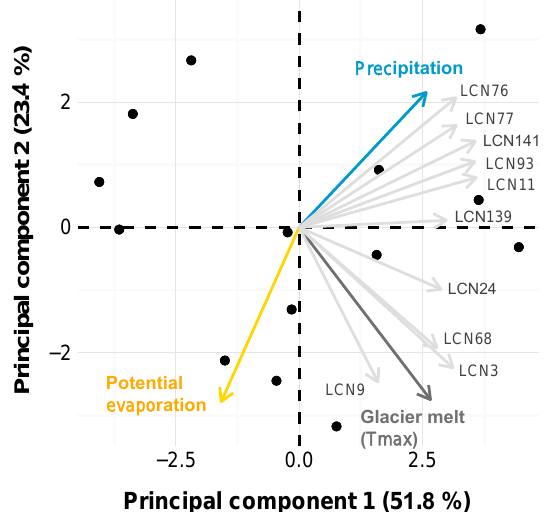
Figure 5. Principal component analyses (PCAs) between pond sur- face area from 2000 to 2013 and potential drivers of change (precip- itation, glacier melt, and potential evaporation) related to the mon- soon season. Coefficients of correlation are reported in Table S5. All trends related to ponds and variables are provided in Figs. S5 and